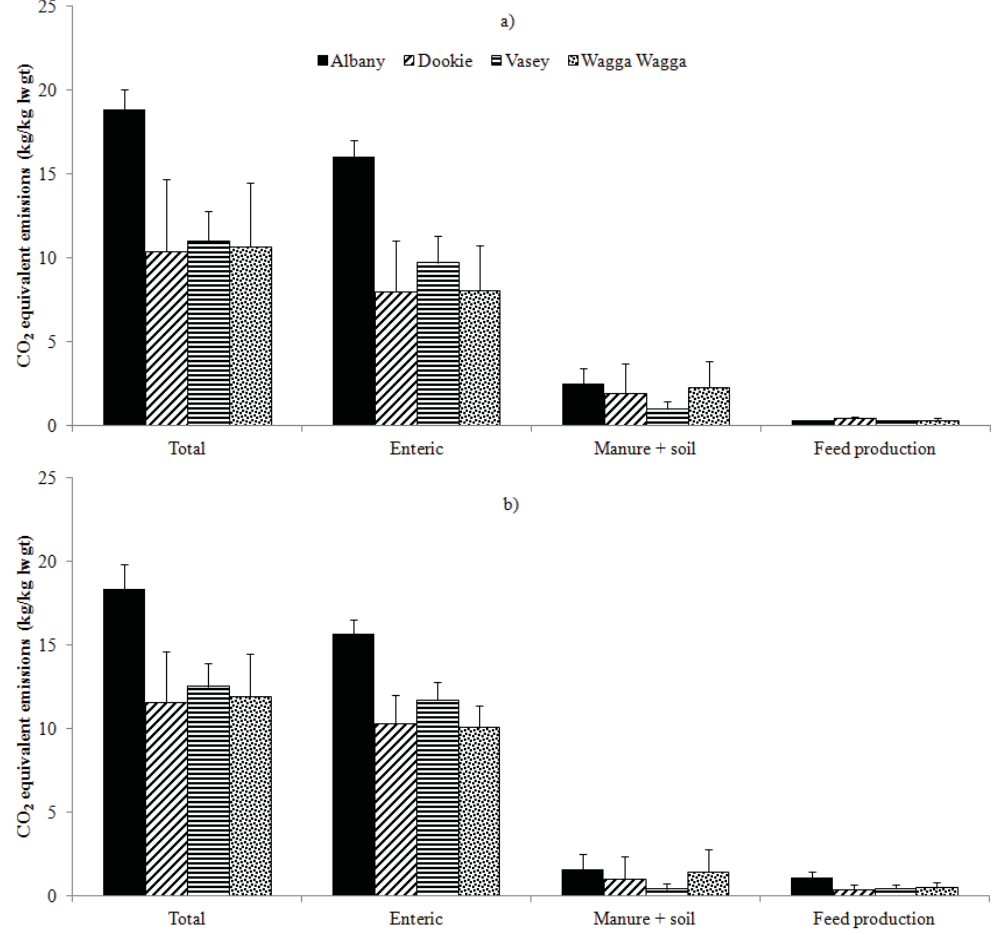
-eq.) equivalent emissions per Figure 2. Predicted average annual carbon dioxide (kg CO 2 kg calf live weight at weaning (kg lwgt) from all sources (total), enteric fermentation, manure and soil, feed production (pasture, forage and bought-in grain) at Albany, Dookie, Vasey and Wagga Wagga for the years 1971 to 2000 for cows fed a) pasture or b) pasture and supplementary feed. Vertical bars indicate standard deviation for 30-year model